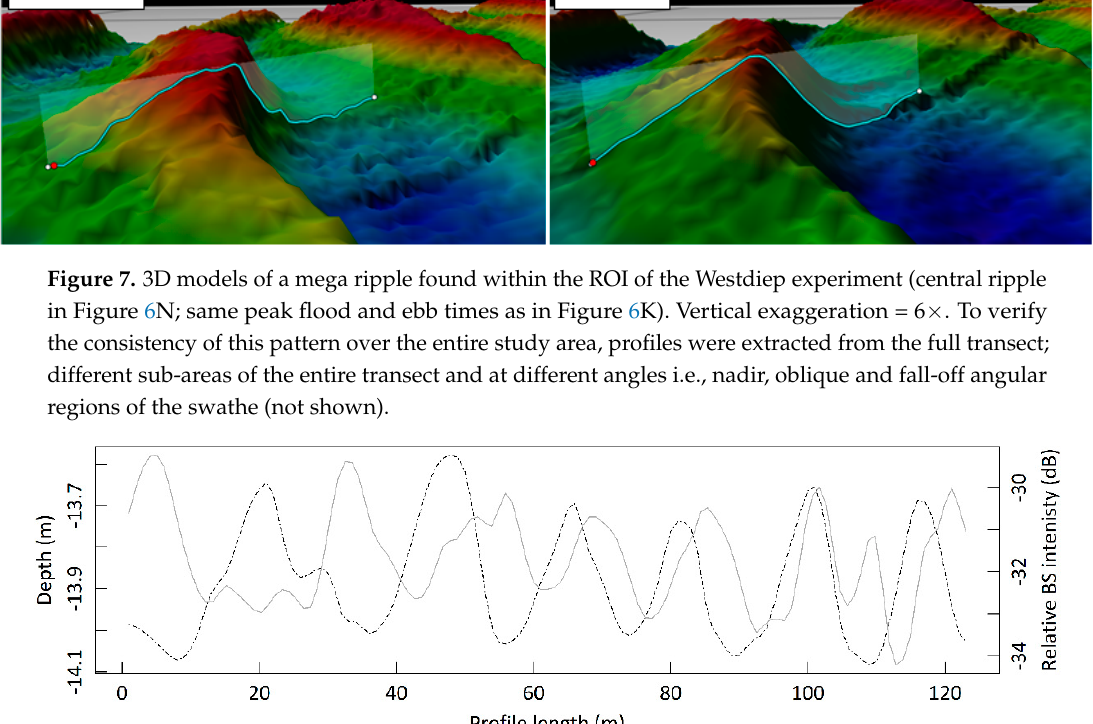
Table 5. Correlation matrix obtained by the Spearman rank method (lower triangle shown). Significance levels of the correlations are denoted by asterisks: Legend of the significance in the bottom row of the table. Values in italic = > 0.7.